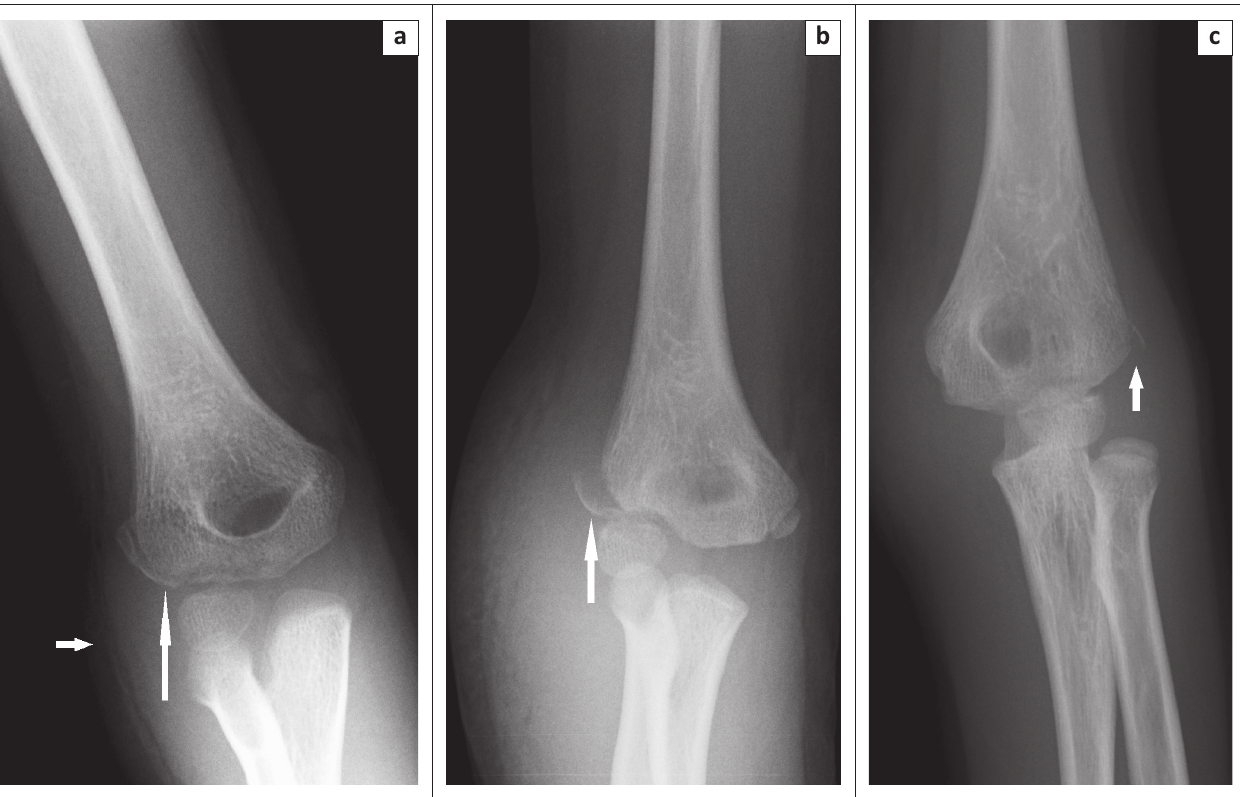
FIGURE 10: (a) Undisplaced right lateral condyle fracture (long arrow). Note lateral soft tissue swelling (short arrow). (b) Displaced right lateral condyle fracture (arrow). (c) Internal oblique showing left lateral condyle fracture that was suspected but not visible on the AP